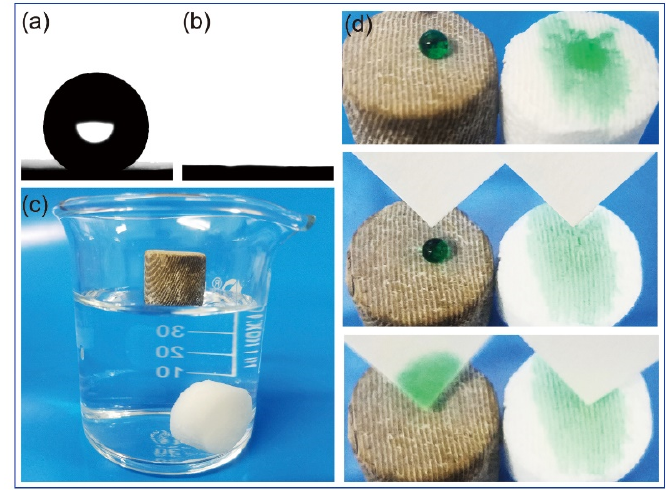
Figure 4. ( a ) Photograph of a water droplet on the surface of a superhydrophobic cuttlebone sample, ( b ) photograph of a water droplet on the surface of an untreated cuttlebone sample, ( c ) photograph of an untreated cuttlebone sample and a superhydrophobic cuttlebone sample placed in a beaker with water, ( d ) snapshots of the water-repelling test of the samples.